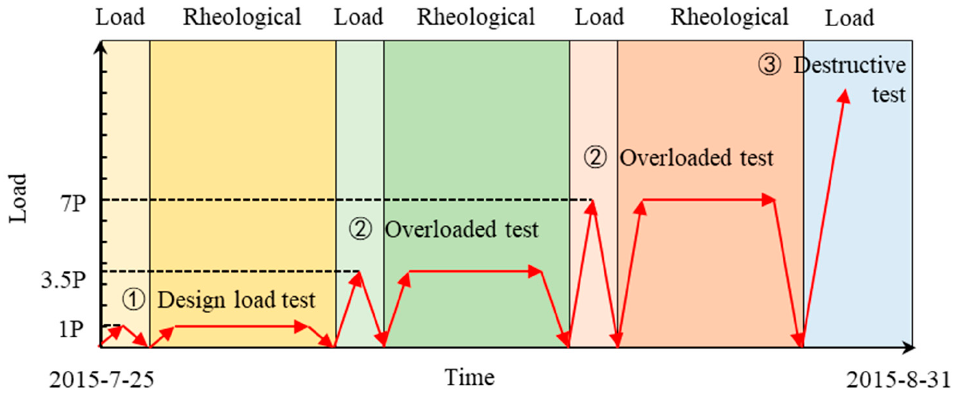
Figure 4. Schematic diagram of the loading steps of the anchor test.